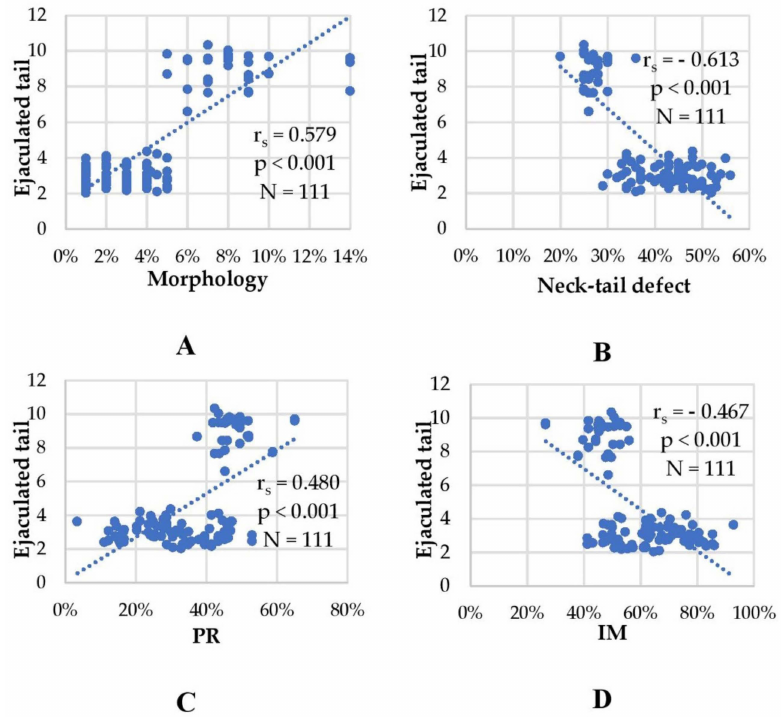
Figure 5. Correlation between the area of expression of tACE protein in the tail (neck and mid- piece) and sperm characteristics of ejaculated spermatozoa. Scatter plots showing the tACE protein expression area in the neck and mid-piece related to percentage of sperm with normal morphology ( A ); percentage of sperm with defect in neck and mid-piece ( B ); percentage of sperm with progressive motility (PR) ( C ); percentage of immotile sperm ( D ). Due to the absence of a normal distribution in most indicators and the heteroscedasticity of the points in the scatter plot, the nonparametric Spearman rank coefficient (r s ) was